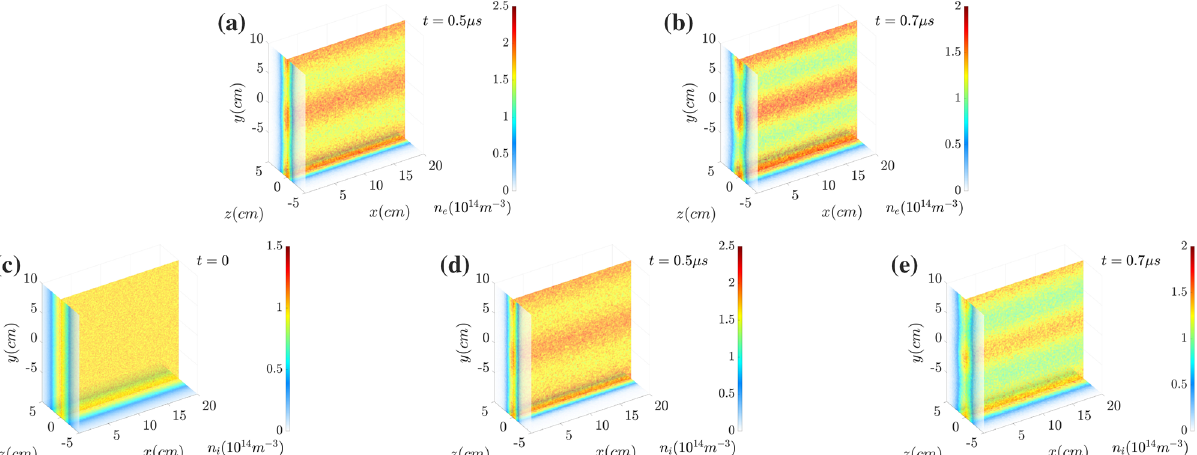
Figure 2. Spatial distribution of the electron number density n e at ( a ) t = 0.5 µ s and ( b ) t = 0.7 µ s , and the proton density n i at ( c ) t = 0 , ( d ) t = 0.5 µ s and ( e ) t = 0.7 µ s . The electron sheet current is filamented along the z = 0 plane, and the ions also follow the filamentation.